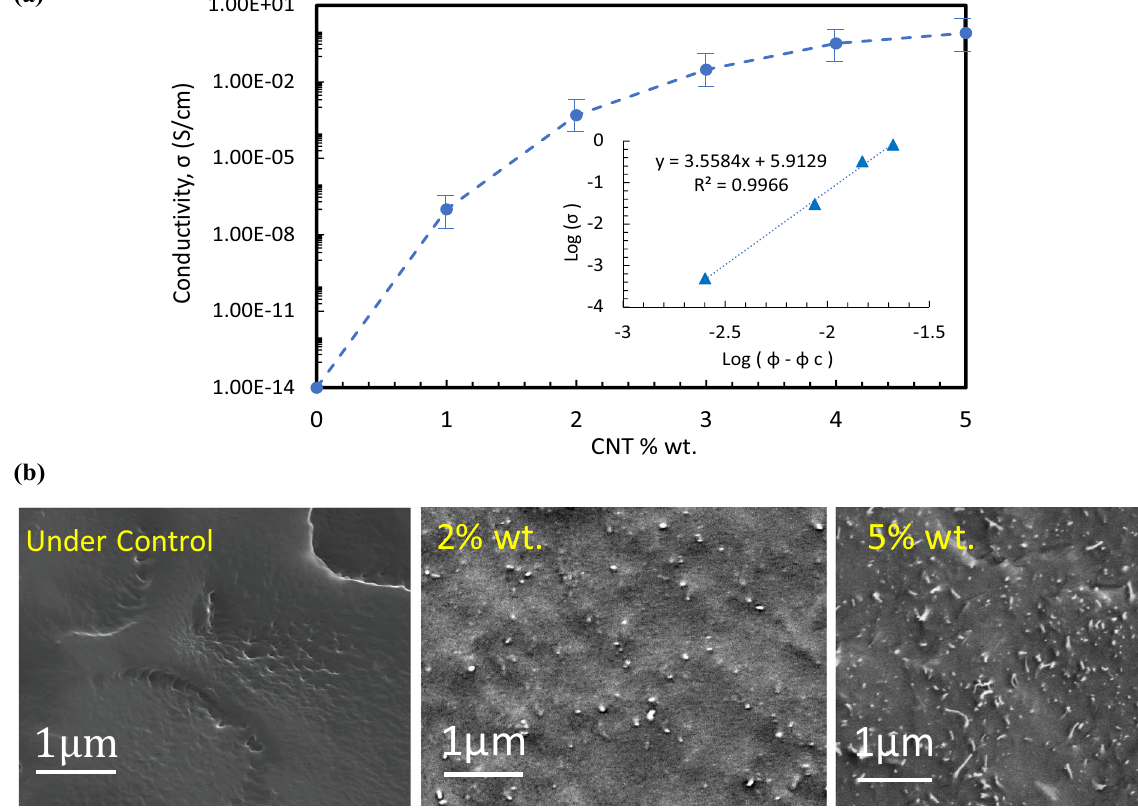
Figure 3. Electrical conductivity and CNTs distribution. ( a ) Electrical conductivity of TPU/CNT samples vs. CNT content wt% are employed to do calculation of percolation threshold. ( b ) SEM distribution images of cross-section fracture surface of the neat, 2 wt% and 5 wt% MWCNTs in TPU nanocomposite. Bright dots and lines are the carbon nanotubes within the polymer